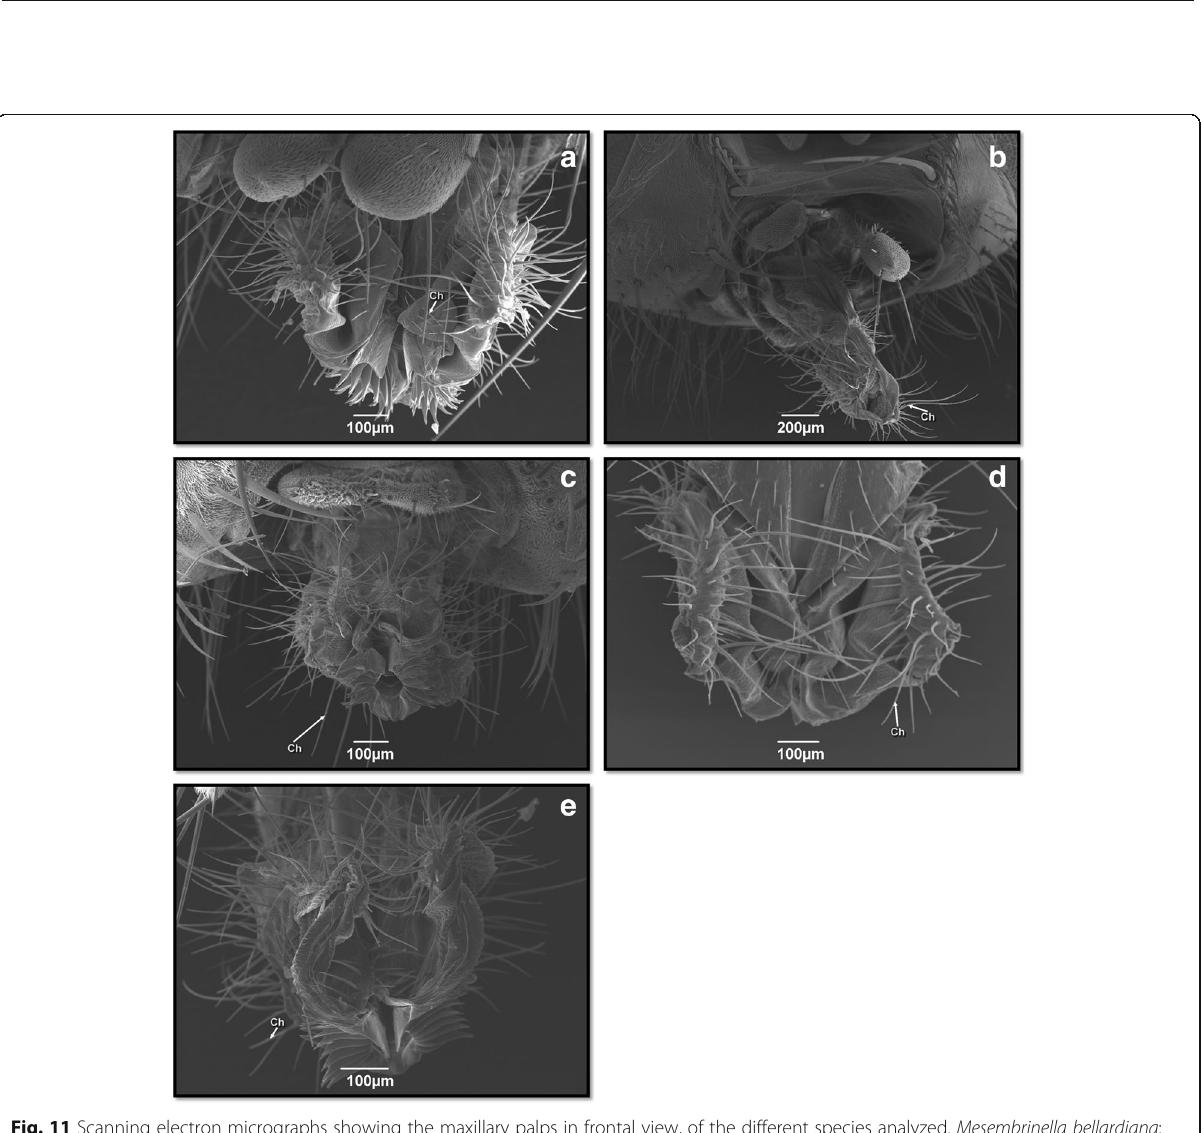
Fig. 11 Scanning electron micrographs showing the maxillary palps in frontal view, of the different species analyzed. Mesembrinella bellardiana : a female (× 110), b male (× 60). Mesembrinella bicolor : c female (× 110), d male (× 130). Mesembrinella semihyalina e male (× 150). Ch = chaetic